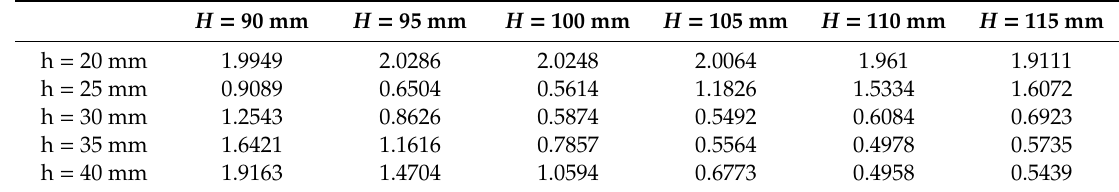
Table 1. Flow maldistribution degree S (10 −2 kg/s) under different combinations of inlet header height H and splitter plate height h.